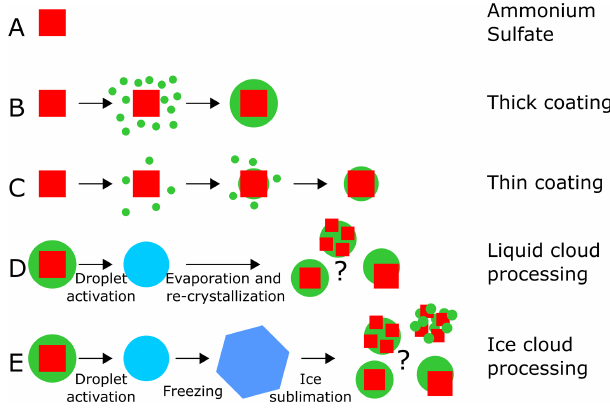
Figure 1. Summary of the experiments performed. Experiment A: crystalline ammonium sulfate (AS). Experiment B: AS crystals thickly coated with secondary organic matter (SOM) from the ozonolysis of α -pinene (AP) at + 20 ◦ C in the aerosol preparation and characterization (APC) chamber (thick coating). Experiment C: AS crystals stepwise coated with small amounts of SOM from the ozonolysis of AP at upper tropospheric temperature in the AIDA chamber (thin coating). Experiment D: in situ crystallization of the AS component from a homogeneously mixed, aqueous droplet that was generated by the droplet activation of crystalline AS aerosol thickly coated with SOM (prepared as in experiment B). Experi- ment E: aerosol prepared in the same way as in B but then sub- jected to an atmospheric freeze-drying process, involving droplet activation, freezing, and ice sublimation. A detailed description of the experiments is provided in the main